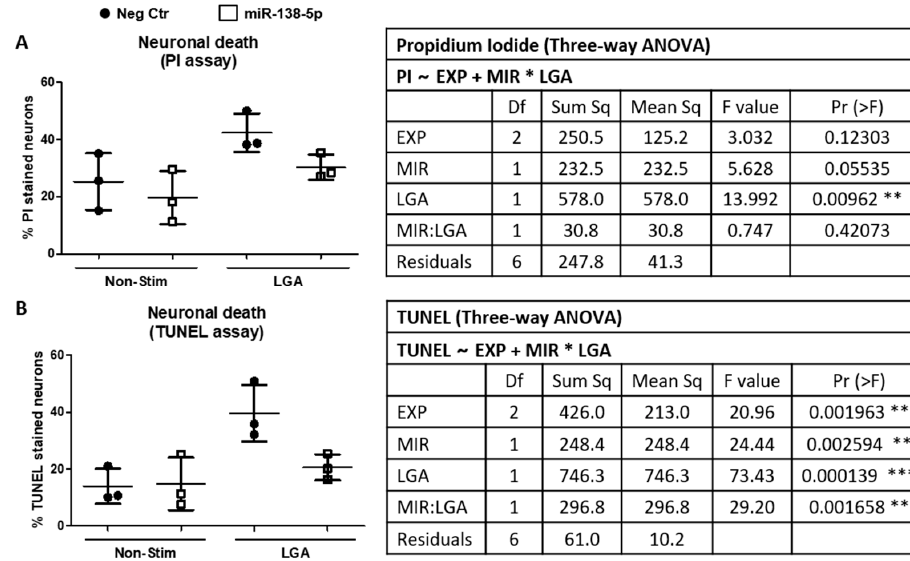
Figure 3. Effects of miR-138-5p transfection on neuronal death after LGA treatment. Neuronal death was analyzed in hippocampal neuron cultures transfected with either miR-138-5p (white squares) or negative control (Neg Ctr; black circles) mimics followed by LGA stimulation. ( A ) PI death assay. ( B ) TUNEL assay. Graphs represent the average of three independent experiments ± SD. The attached tables detail the results from the three-way ANOVA analyses. PI ~ EXP + MIR*LGA or TUNEL~EXP + MIR*LGA describes the employed ANOVA block design to determine whether PI or TUNEL variables depend on a block factor (experiment, EXP) and two independent variables (MIR for miR-138-5p transfection; and LGA for LGA stimulation) whose effects may depend on the values of the other independent variable (interaction term, MIR:LGA). *, ** and *** denote significant differences: p < 0.05, p < 0.01 and p < 0.001, respectively.